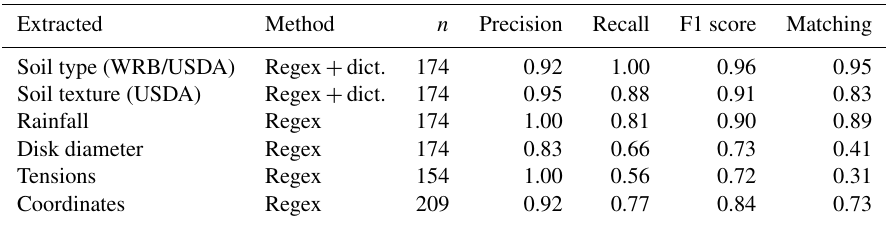
Extracted Method n Precision Recall F1